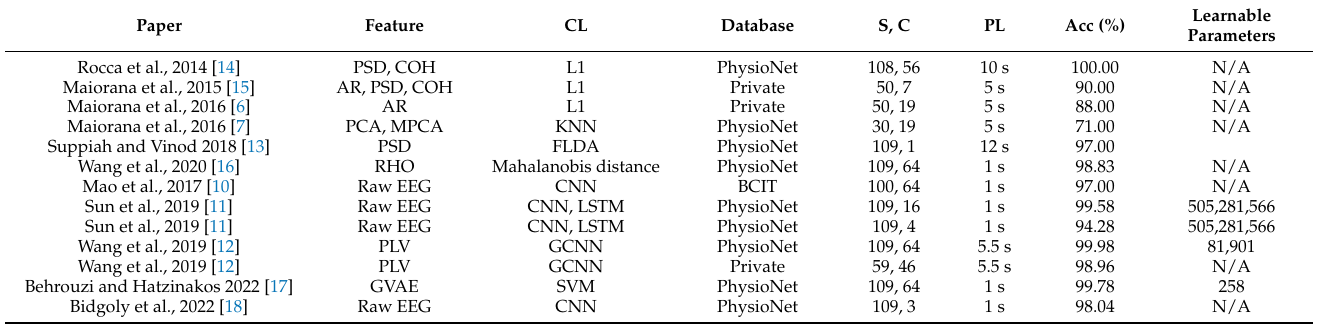
Table 1. EEG-based Identification Methods. Notations: CL—Classifier, S—Subjects, C—EEG